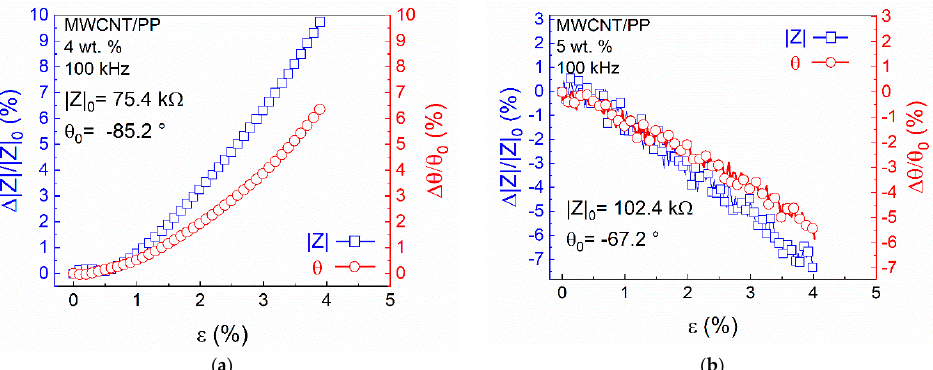
Figure 5. Piezoimpedance response of the nanocomposites in the dielectric configuration. ( a ) 4 wt.%; ( b ) 5 wt.%.